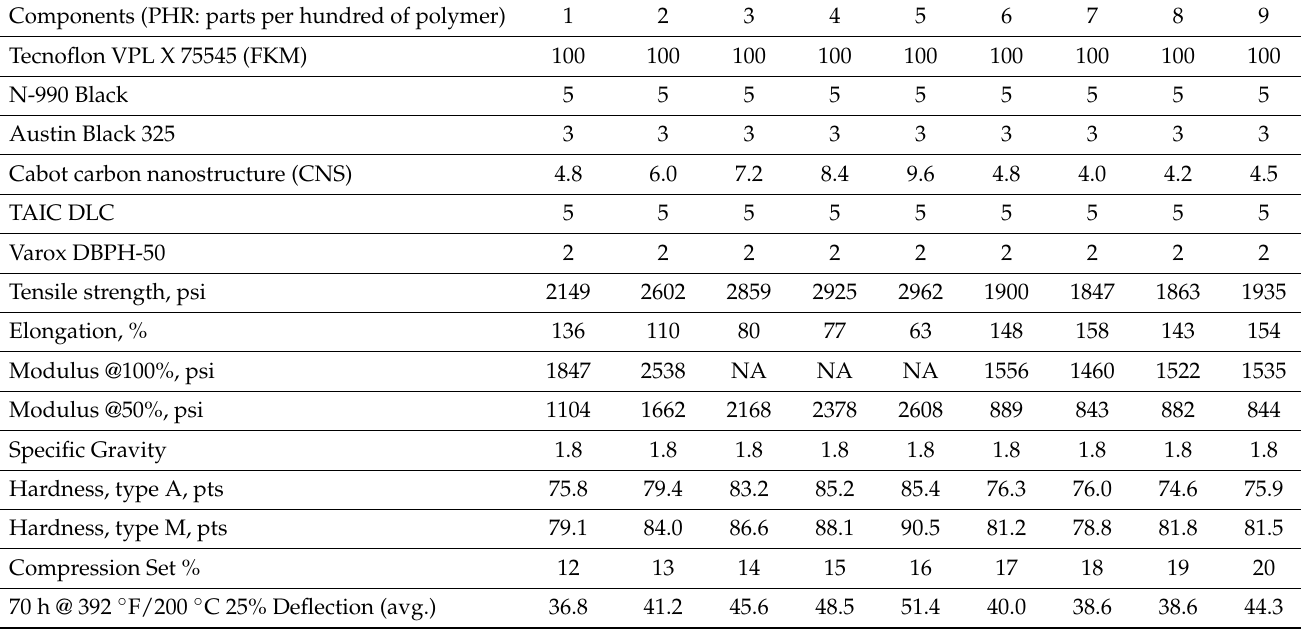
Table 1. Compositions of the FKM samples